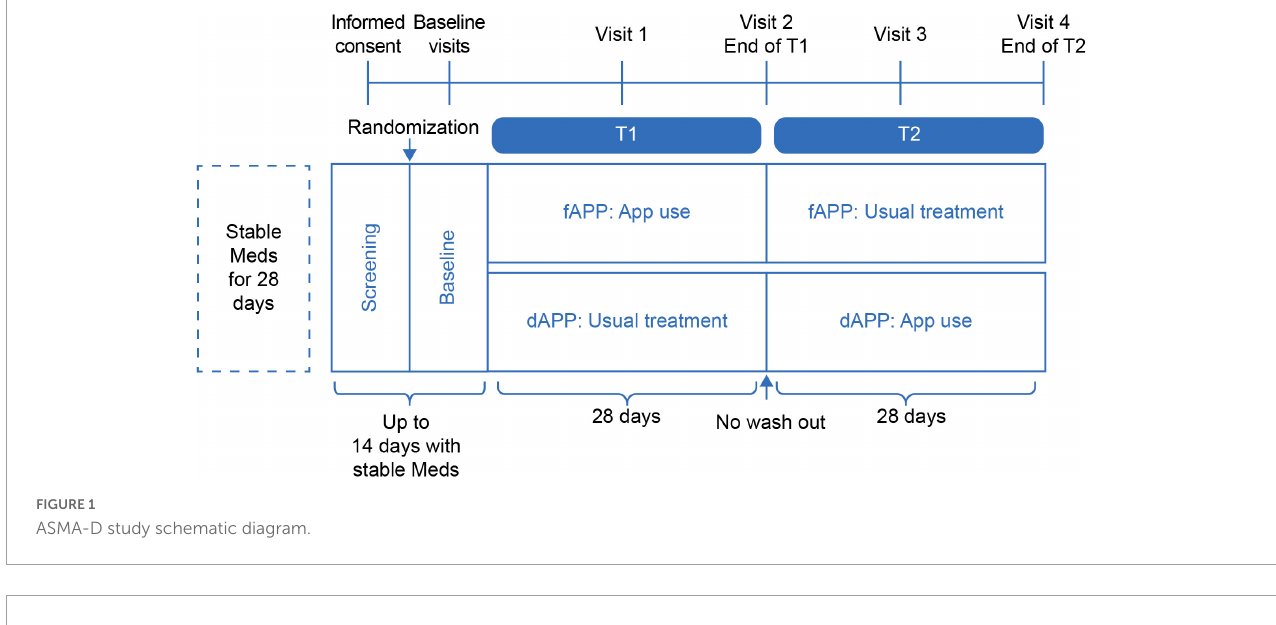
FIGURE1 ASMA-D study schematic diagram.